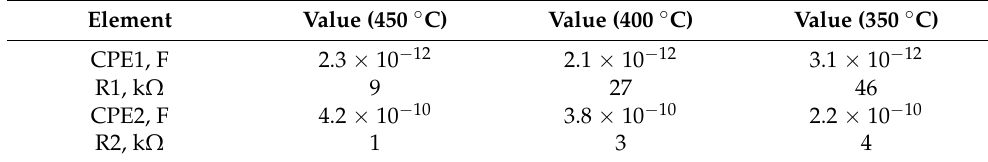
Table 4. The Nyquist plots fitting results.